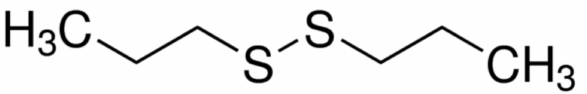
Figure 1. Structure of propyl